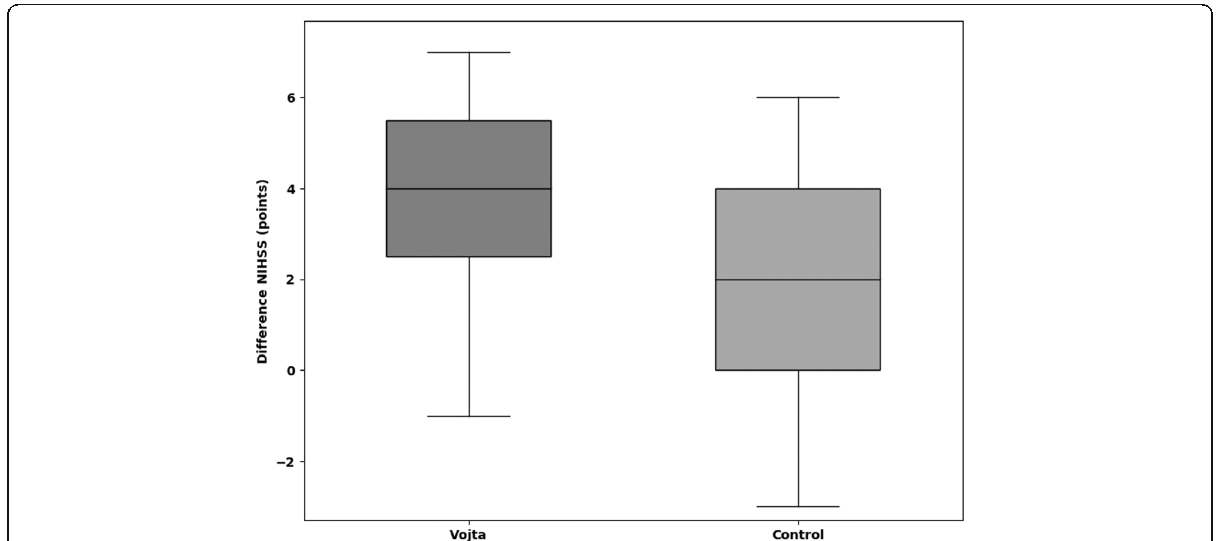
Fig. 5 Difference in National Institutes of Health Stroke Scale (NIHSS) scores between baseline and day 9. The median improvement in the NIHSS within 9 days was 4 points (=9.5%) (IQR2.5 – 5.5) in the Vojta group and 2 points (= 4.8%) (IQR 0 – 4) in the control group ( p = 0.022). Data